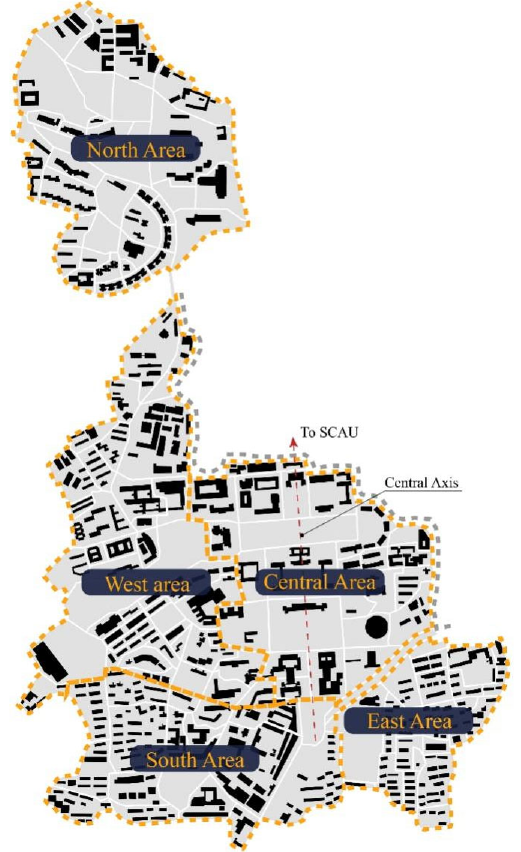
Figure 4. Zoning map of Wushan Campus of SCUT.